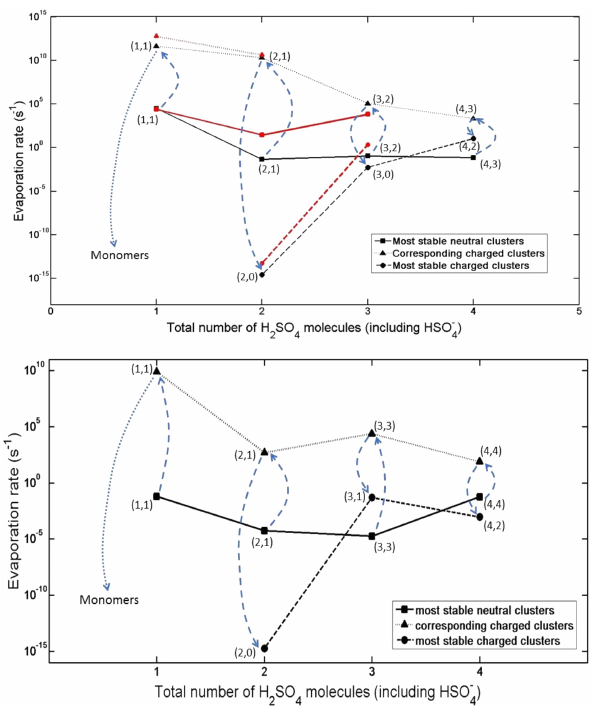
Figure 5. Comparison of the total evaporation rates at 298.15K (s − 1 ) of neutral clusters (solid lines), negatively charged clusters obtained by removing a proton (dotted lines) and the most stable negatively charged clusters with the same number of sulfuric acid molecules (including the bisulfate ion, dashed lines). Black lines represent evaporation rates from this work and red lines represent evaporation rates obtained using the formation free energies by Herb et al. (2013). Numbers in parentheses indicate the composi- tion of the cluster (acids, bases). Blue arrows illustrate the charging process and the resulting most stable charged cluster. Top panel: ammonia-sulfuric acid clusters. Bottom panel: DMA-sulfuric acid